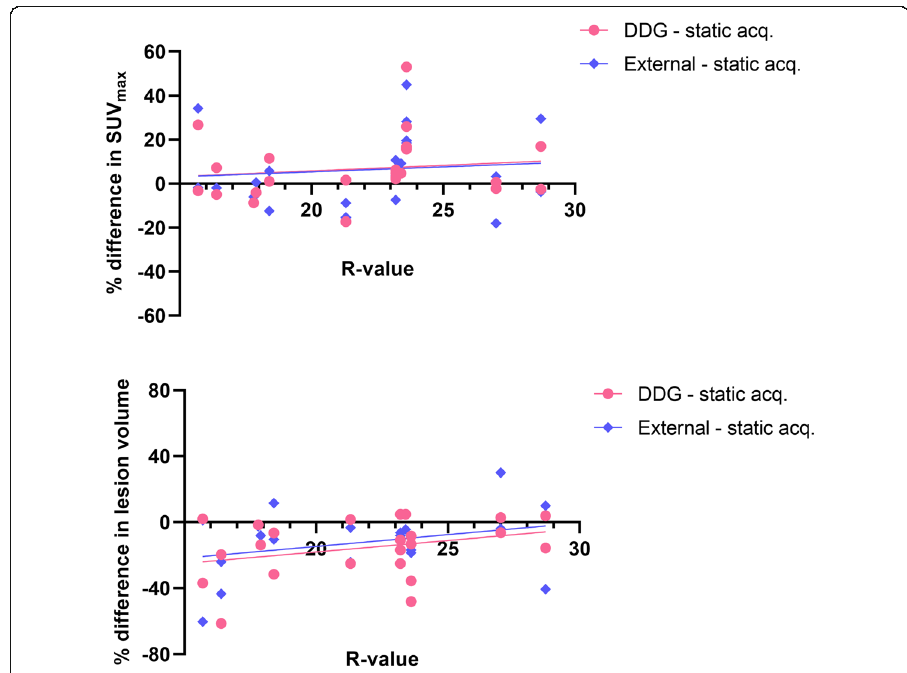
Fig. 6 Correlation between DDG R value and difference in SUV max (upper) respectively difference in lesion volume (lower). A week trend in the data can be seen, but the R 2 < 0.2 and is not